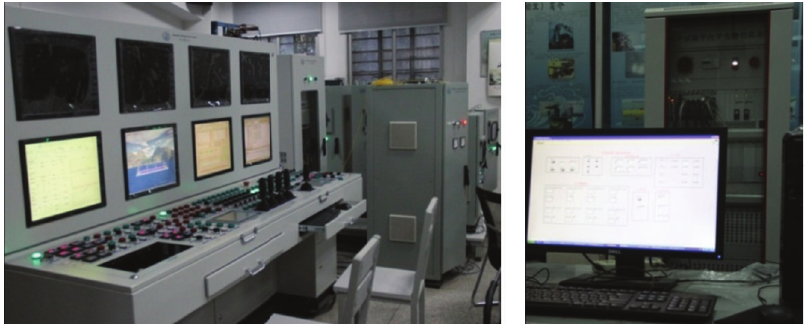
Figure 12: Actual controller and hardware-in-loop